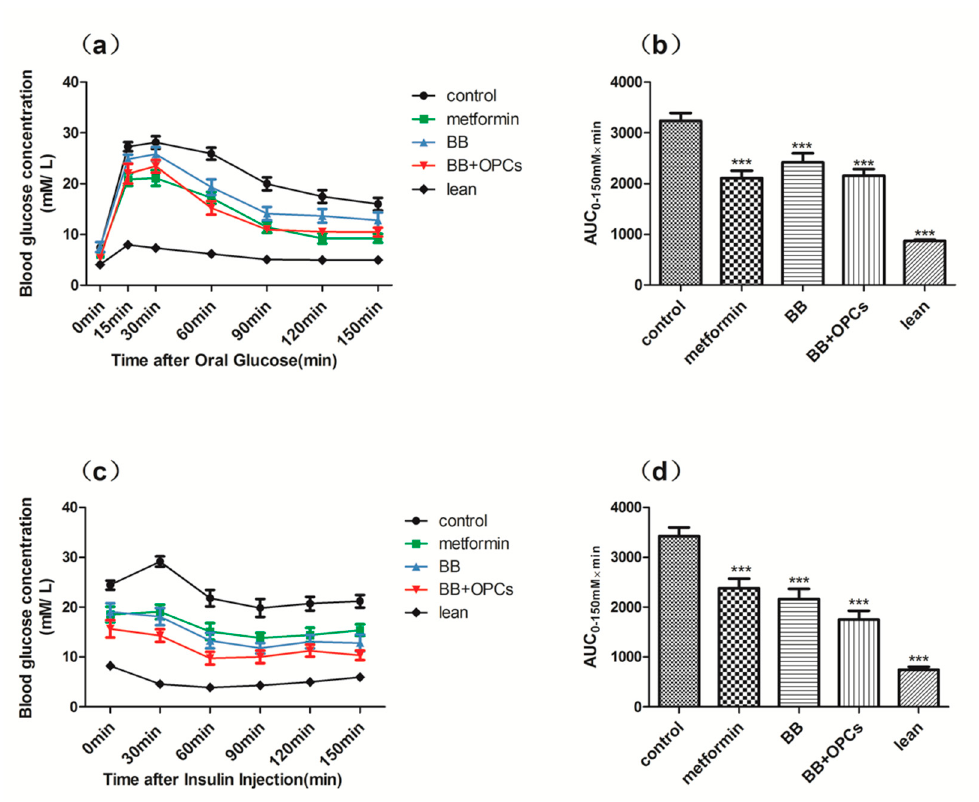
Figure 2. Effects of the 5 weeks administration of compounds in the ( a ) OGTT and ( c ) IPTT in db / db mice with diabetes. ( a ) After 14 h of fasting, 0.35 g of glucose per kilogram of body weight was gavaged into mice and calculated as 0 min. Blood glucose levels were measured at the indicated times shown in the graph. ( c ) After 6 h of fasting, blood glucose concentrations were measured at the indicated time following intraperitoneal injection of 1 IU of insulin per kilogram of body weight. AUCs for ( b ) OGTT and ( d ) IPTT are shown in the graph. Data are presented as mean ± SEM of eight mice in each group. *** p < 0.001 vs. untreated control.